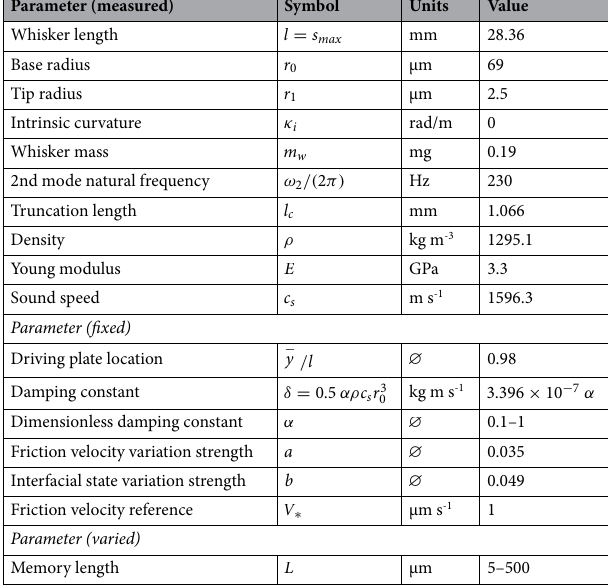
Table 1. List of all input parameters of the Cosserat and the friction